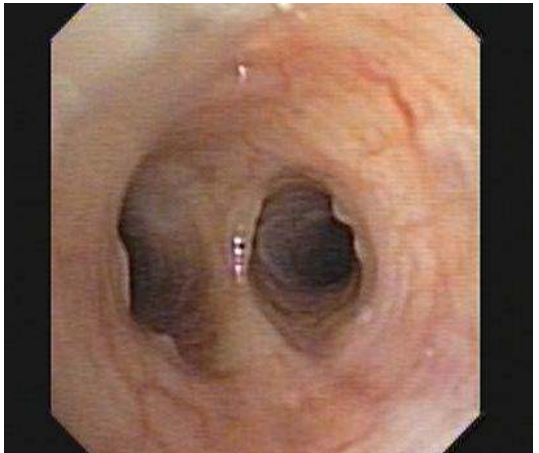
Figure 3: CT Thorax:multiple sclerotic lytic vertebrae(D8,D9,D10 and D12) and lytic cystic ribs(1,2,8,9,12 on right side and 8 th rib on left side)